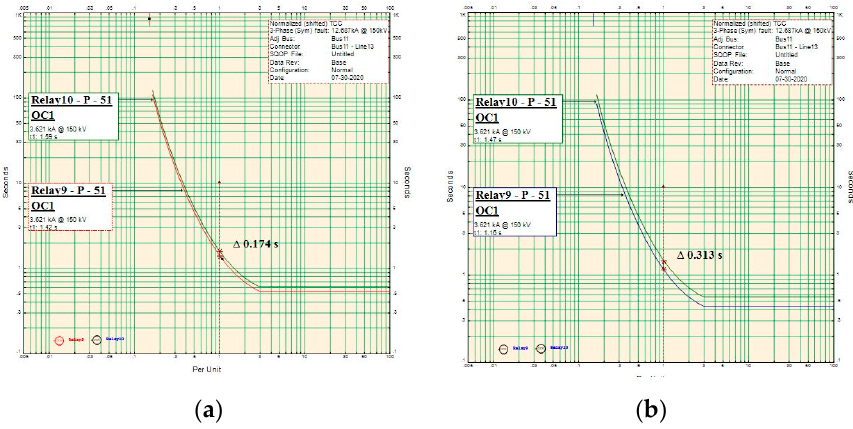
Figure 12. Primary and backup relay pair characteristics for relay pair 6 ( a ) with conventional settings, and ( b ) with settings updated using the proposed algorithm.